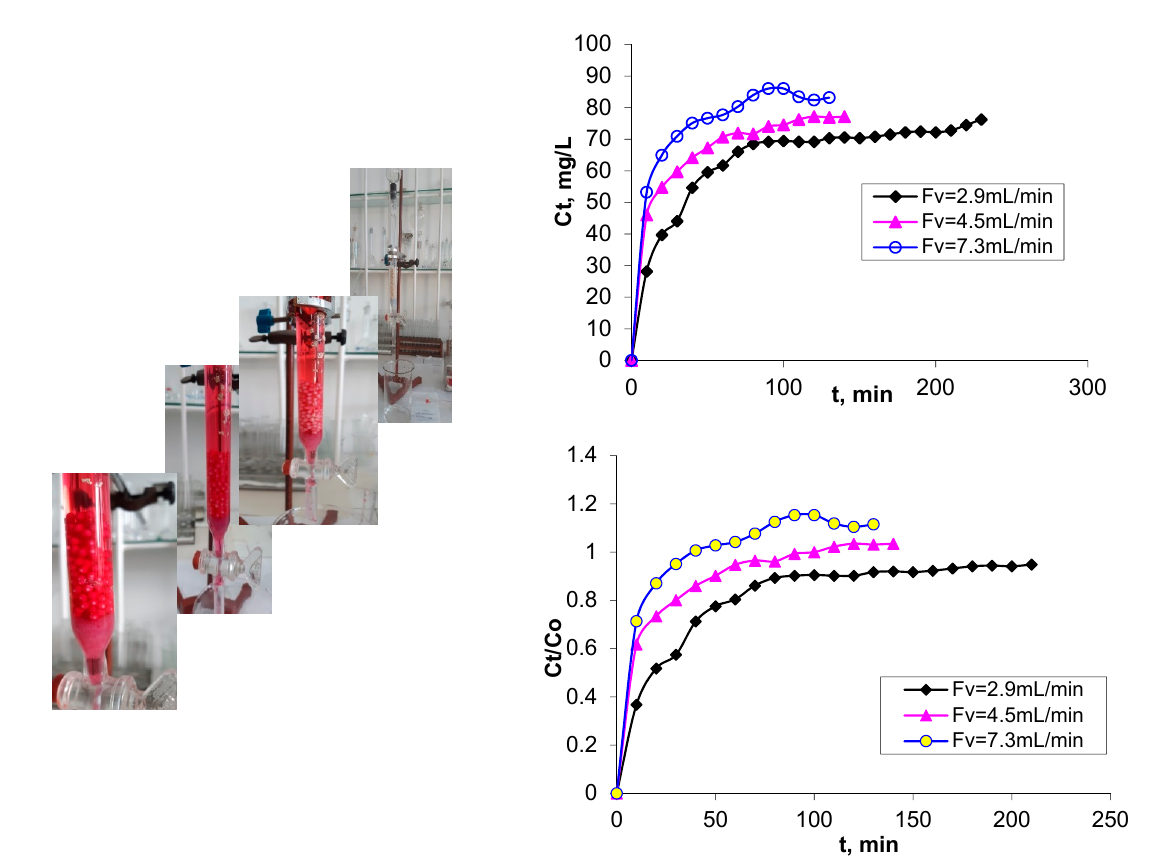
Figure 2. The breakthrough curves for the biosorption system in a dynamic regime: BRed dye—residual Bacillus sp . biomass immobilized in alginate. Operating conditions: T = 20 °C; C 0 = 76.72 mg/L; pH = 3.